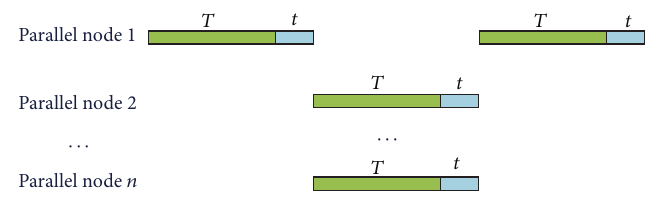
Figure 8: The computing cycle in the basic scheme.